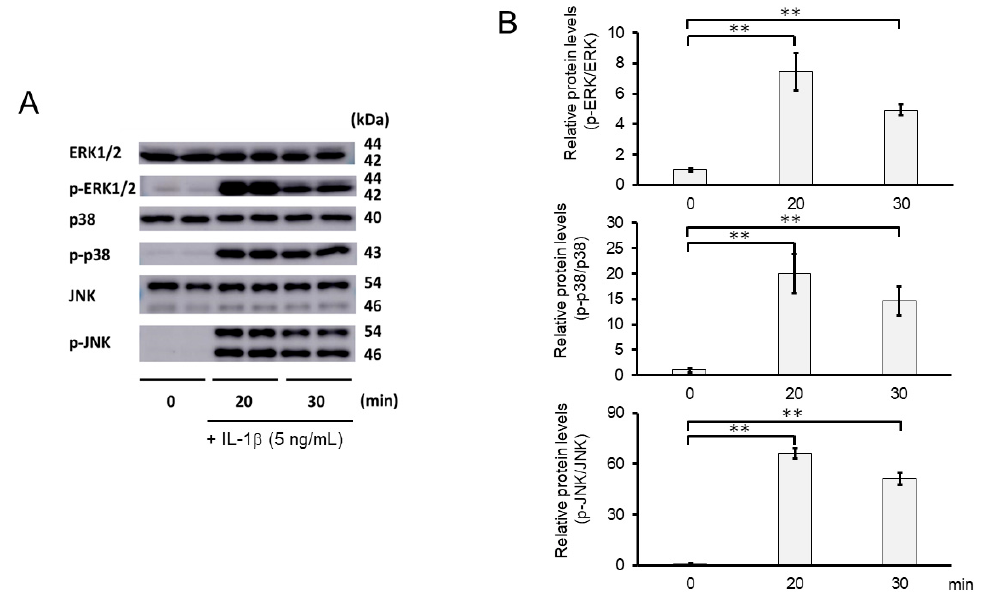
Figure 8. Activation of MAPK signaling pathway in IL-1 β -stimulated OUMS27 cells. ( A ) Western blot analysis of the relative phosphorylation levels of Erk1/2, p38, and JNK after IL-1 β treatment. Phosphorylation of Erk1/2, p38, and JNK increased significantly after 20 min of treatment with 5 ng/mL IL-1 β , and decreased after 30 min. ( B ) Quantitative estimation of the relative phosphorylated protein levels of Erk1/2, p38, and JNK at given time points. Values represent mean ± SE ( n = 3 per group). ** p < 0.01.